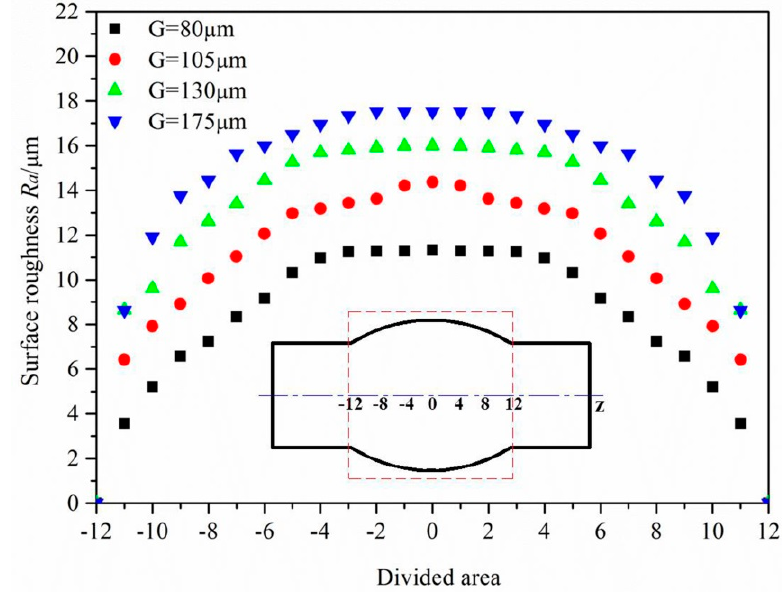
Figure 8. Surface roughness distribution of bulged tubes with different grain sizes.